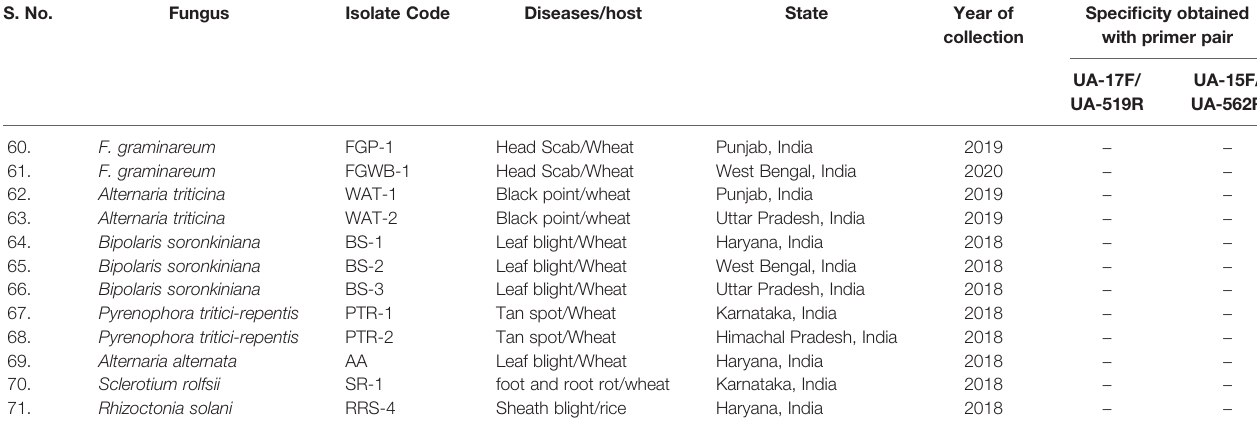
( Figure 1 ). Primers were designed from the regions conserved for U. agropyri (Syn = Urocystis tritici ) and unmatched with other closely related species using Primer 3 program (Untergasser et al., 2012). OligoAnaylzer (https://www.idtdna.com/pages/tools/oligoanalyzer) program was used for checking oligonucleotide properties such as melting temperature, mismatches and formation of hairpins and dimers etc. The speci fi city of the designed primer sets were also checked in silico by searching against the nonredundant (nr) sequences from other organisms via Primer- Basic Local Alignment Search (BLAST) tool (https://www.ncbi.nlm.nih.gov/ tools/primer-blast) of National Center for Biotechnology Information (NCBI) with default parameters. The primers were compared to the database by using FASTA and BLAST to con fi rm speci fi city. The PCR conditions were optimized using U. agropyri FLS1astemplateDNA.PCRreactioncocktail(25 m l)waspreparedby